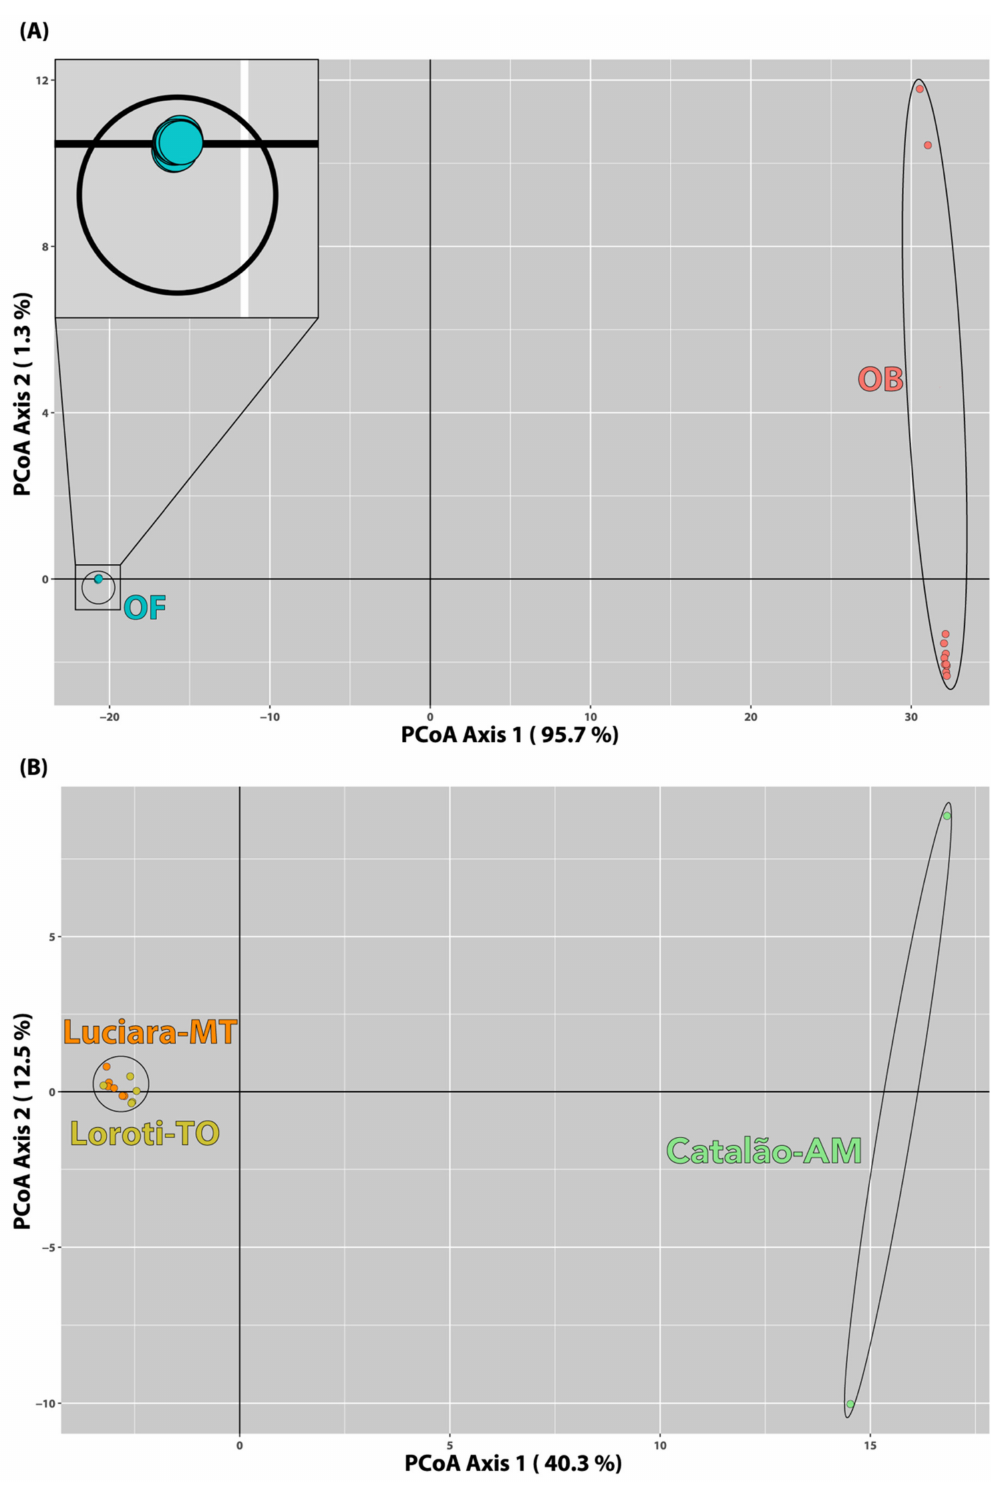
Figure 4. ( A ) Principal coordinate analysis of O. ferreirai (blue) and O. bicirrhosum samples (red). Insert shows a zoom in O. ferrerai samples. ( B ) Principal coordinate analysis of O. bicirrhosum samples, with AMb samples (green) and both TAb localities, Luciara (orange) and Loroti